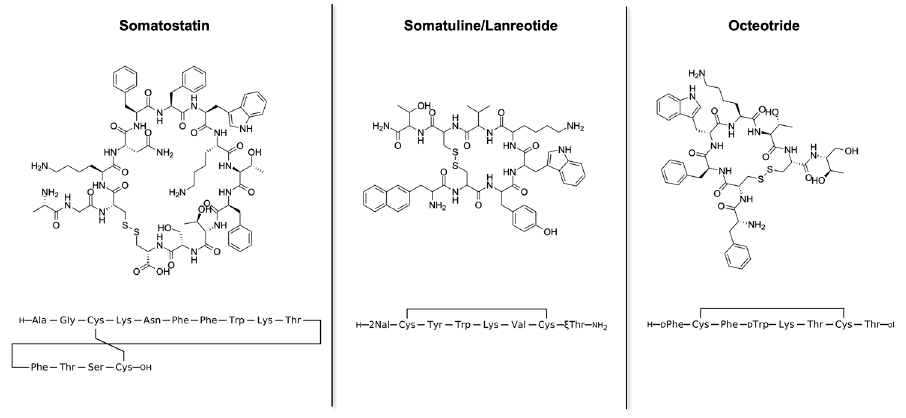
Figure 1. Somatostatin, lanreotide and octreotide peptide structures and sequences.